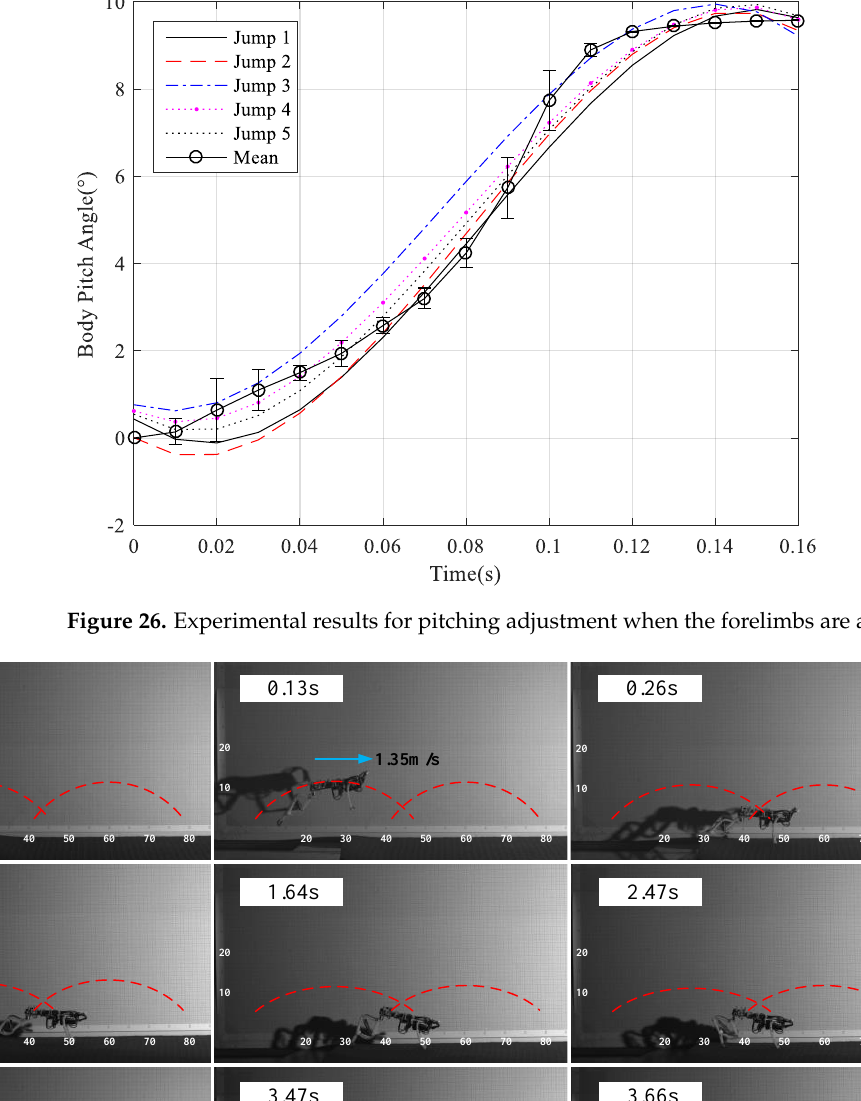
Figure 25. Experimental results for pitching adjustment when the forelimbs are not actuated.